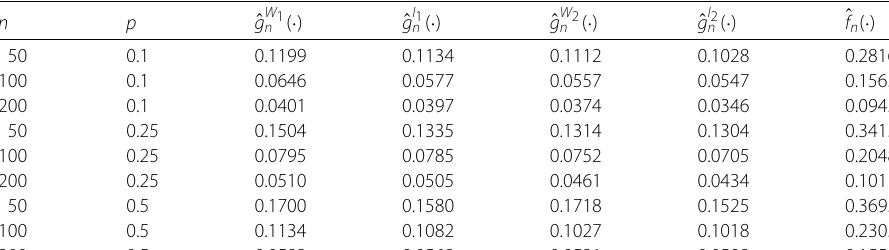
Table 2 The GMSE for the estimators of g ( · ) and f ( · )